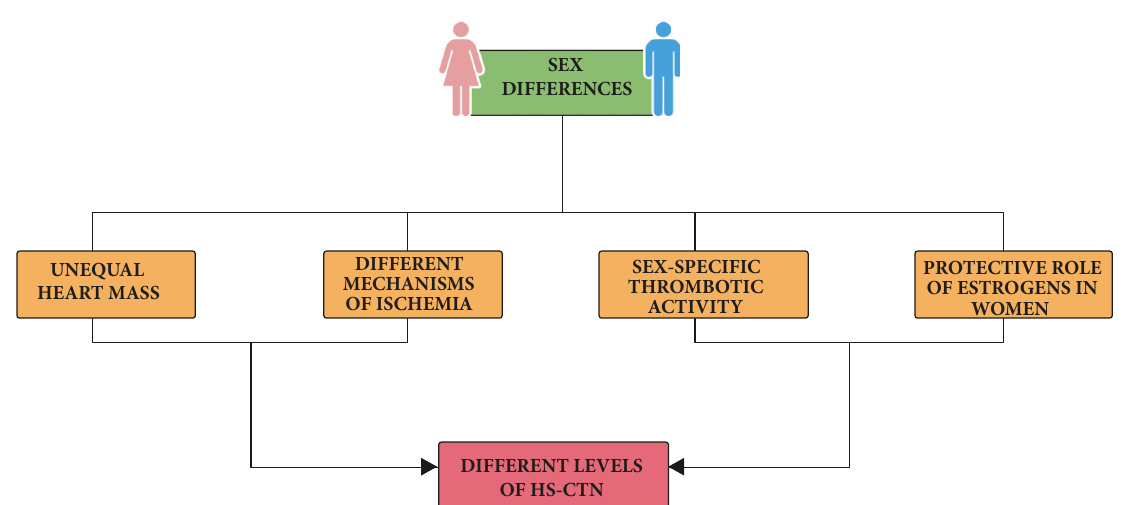
Figure 1: Mechanisms contributing to the discrepancy in hs-cTn levels between men and women.